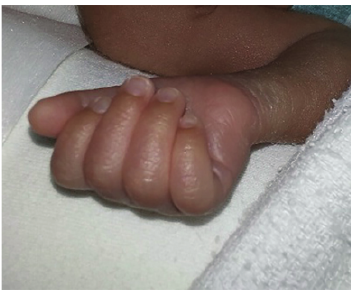
Figure 5: Complete resolution 7 weeks after the